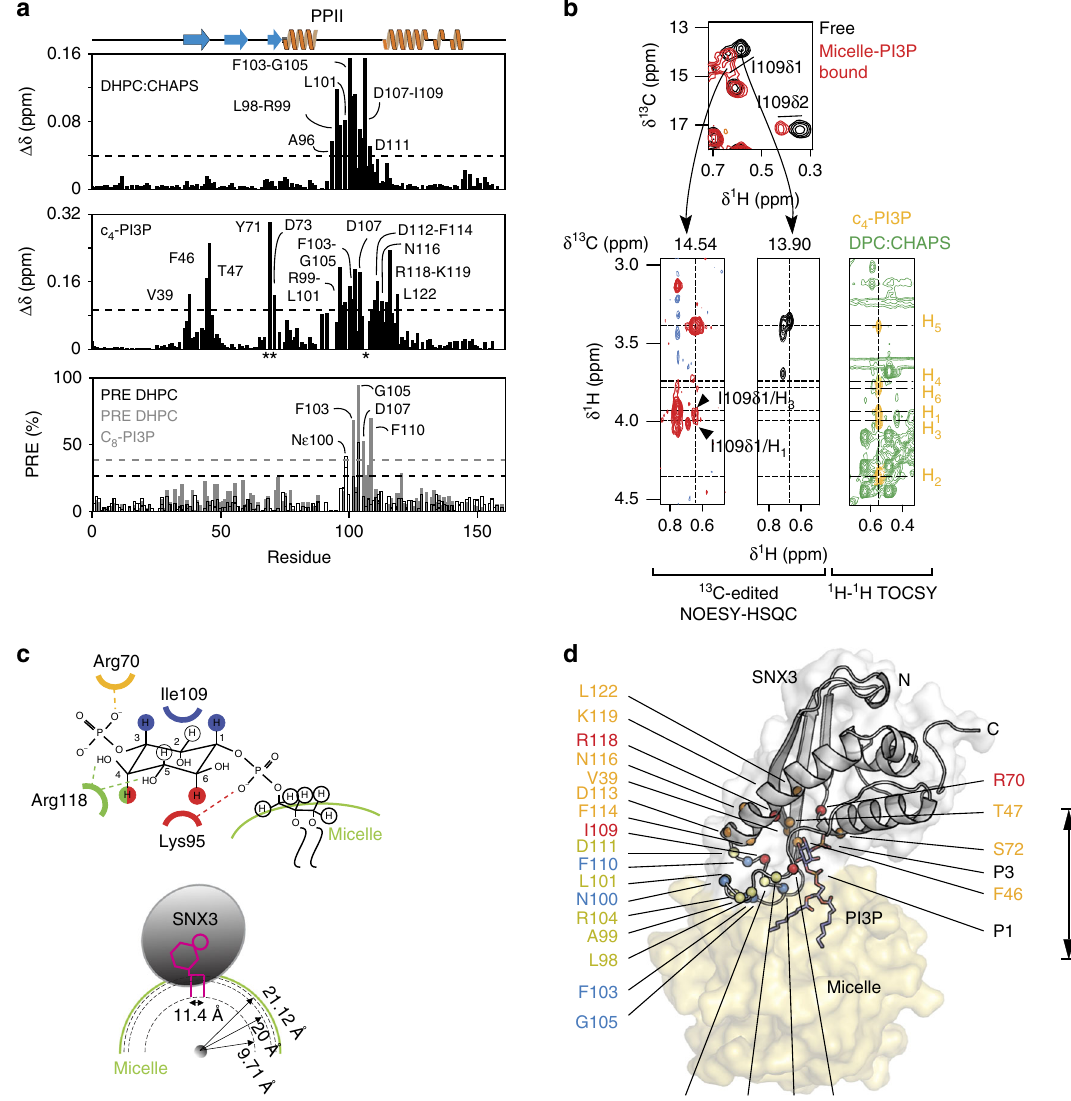
Fig. 3 Model of SNX3 associated bound to micelles. a The experimentally driven molecular docking was based on the interaction of SNX3 with individual components, measuring CSPs for micelles (top) and c 4 -PI3P (middle). Asterisks mark residues with substantially broadened NMR lines. The membrane inserting residues were identi fi ed from PREs (bottom) obtained by adding 5 doxyl PC to 32 mM DHPC:CHAPS micelles in the absence (black) or presence of c 8 -PI3P (gray). b Strips extracted from the 1 H- 1 H planes of 13 C-edited HSQC-NOESY spectra and corresponding to Ile109 ’ s δ 1 13 C resonances are compared for SNX3 bound to micelles and c 4 -PI3P (red) or ligand-free (black). The overlaid 13 C-HSQC spectra show crosspeaks of free and ligand-bound SNX3 (top). The c 4 -PI3P resonances (yellow) are indicated in NMR correlation spectrum alongside the DHPC: CHAPS peaks (green). These asymmetric crosspeaks correspond to intermolecular NOEs between SNX3 and PI3P. c The interactions between PI3P and SNX3 residues are depicted. The recognized non-exchangeable inositol protons are color-coded to match the interacting residue. Conserved hydrogen bonds observed in PX: PI3P structures are represented by dotted lines. d Docked structure of the lowest energy complex between SNX3, PI3P and micelles. Residues active during the docking are indicated on SNX3. Signi fi cant CSPs for Ins(1,3)P 2 (orange) and/or micelles (yellow) are shown. Those involved in intermolecular interactions with PI3P (red) or micelles insertion (blue) are also displayed. The phosphate groups of PI3P are indicated by P1 and P3 protein ’ s long axis into the micelle interior (Table 2) using restraints than has been measured for other PX domains 10,15,16 (Fig. 3d; Table 1). The SNX3 MIL is particularly long, with resi- established protocols 14 . The conservation of the interfacial resi- dues including Arg99, Gln100 or Arg104 exhibiting contacts with dues across the superfamily (Fig. 4) along with MODA-based PI3P and seven PC molecules to orient the protein on the identi fi cation of the respective membrane interaction surfaces 12 in each available PX domain structure indicates that other sorting membrane in such a way that its β -sheet remains accessible to the nexins employ similar membrane binding modes. retromer complex 6 . The extensive PI3P-micelle interface also includes the β 1- β 2 hairpin loop, with Arg43 making electrostatic contacts with PC headgroups, the speci fi c ligand interactions of PI3P site phosphorylation blocks localization . A potential the α 1 and α 2 residues, and bilayer insertion of the PI3P acyl tails. mechanism of regulation of SNX3 ′ s fast and slow release from Together this yields a unique insertion angle of 31.0° ± 5.6° for the NATURE COMMUNICATIONS | (2018) 9:993 | DOI: 10.1038/s41467-018-03370-1 |